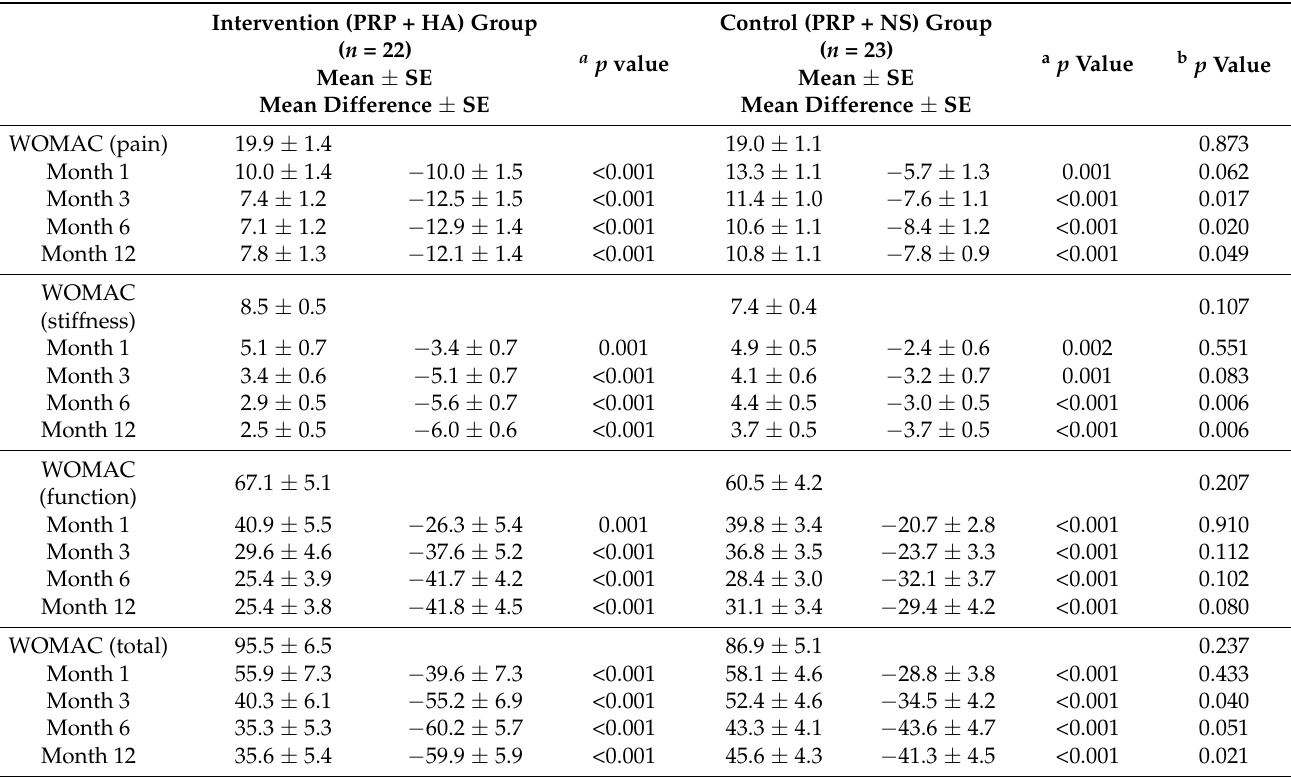
Table 2. Comparison of all WOMAC scores between both